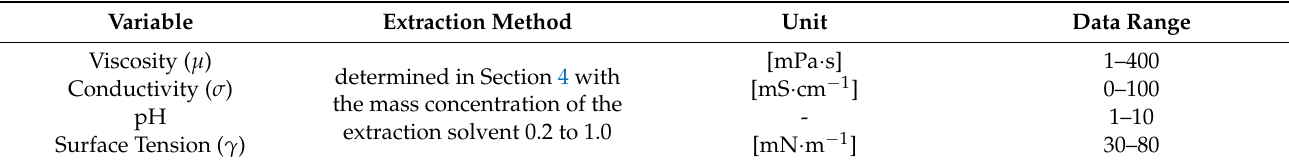
Table 1. Different variable forms for predicting the performance of ionic solution extraction of oily sludge. Variable Extraction Method Unit Data Range Viscosity ( µ ) determined in Section 4 with Conductivity ( σ the mass concentration of the extraction solvent 0.2 to 1.0